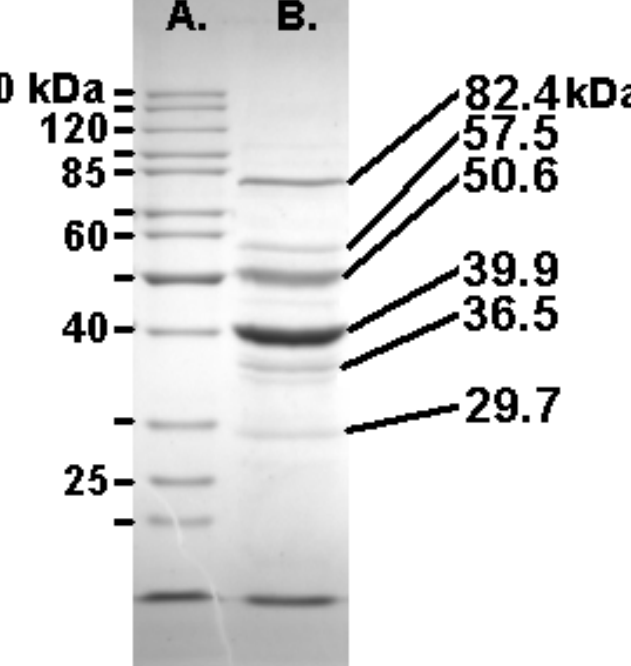
Figure 3. SDS-PAGE (10%) analysis of the structural proteins of Felix O1 with the masses of the Fermentas PageRuler markers (left) and the most abundant proteins